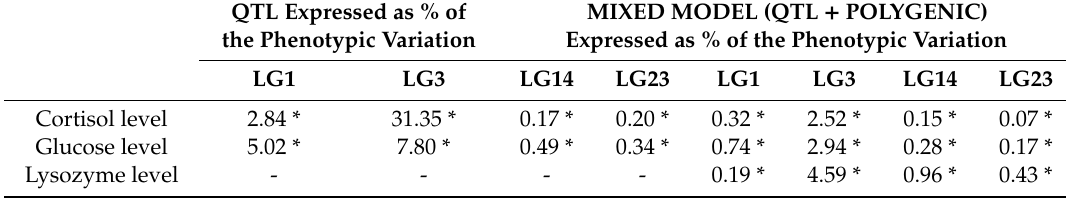
Table 5. Phenotypic variation of all QTLs (QTL heritability) for stress indicator traits: cortisol, lysozyme, and glucose levels. QTL Expressed as % of MIXED MODEL (QTL + POLYGENIC) the Phenotypic Variation Expressed as % of the Phenotypic Variation LG1 LG3 LG14 LG23 LG1 LG3 LG14 LG23 Cortisol level 2.84 * 31.35 * 0.17 *